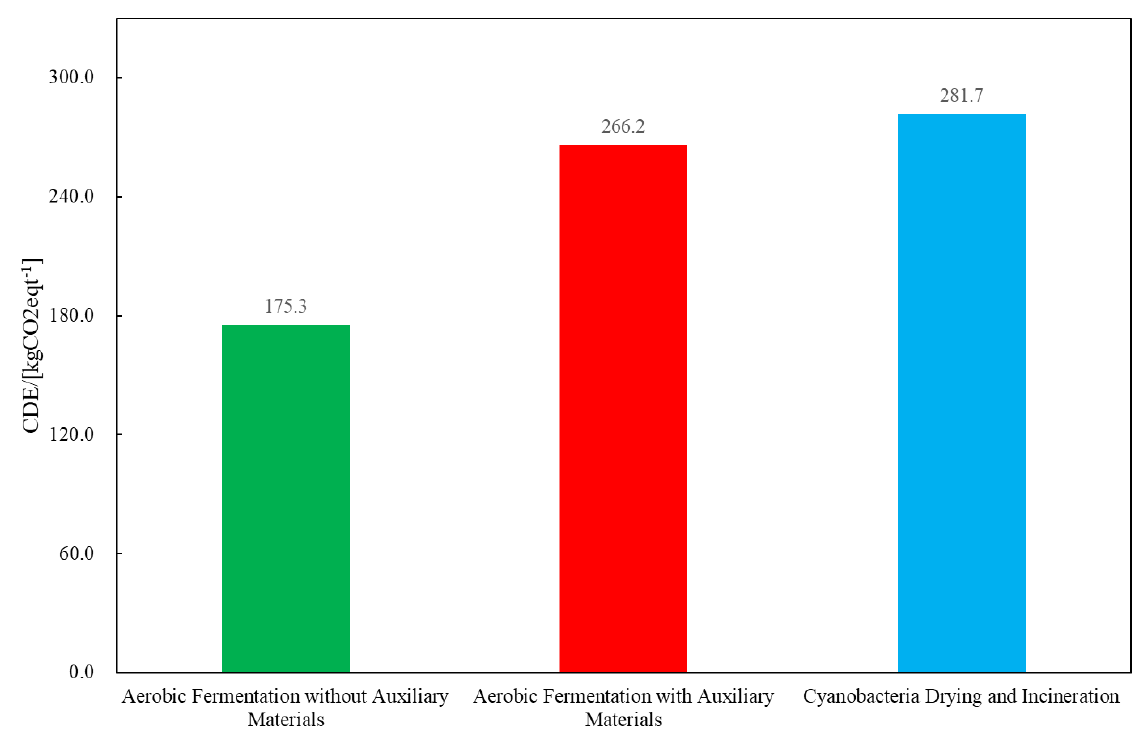
Figure 6. Effects of different cyanobacterial treatments on carbon emission.